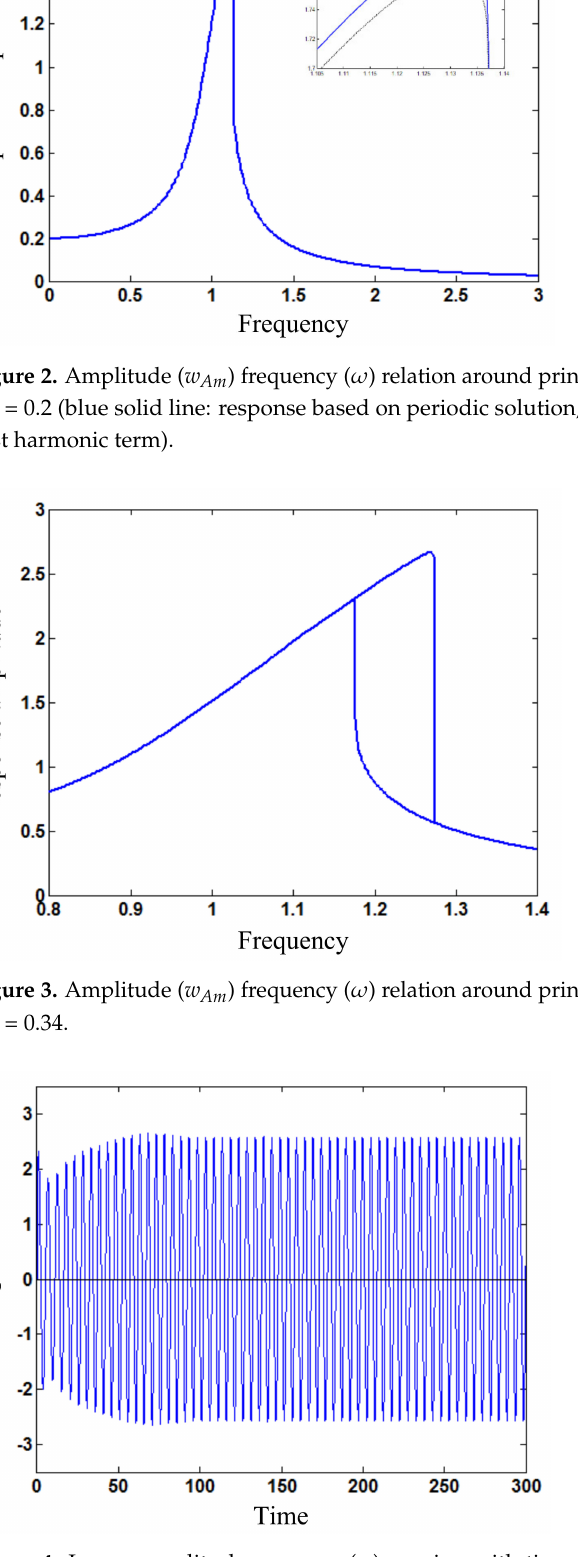
Figure 4. Larger amplitude response ( w ) varying with time ( t ) for loading frequency ω = 1.24 by numerical simulation from initial displacement 1.0 and velocity